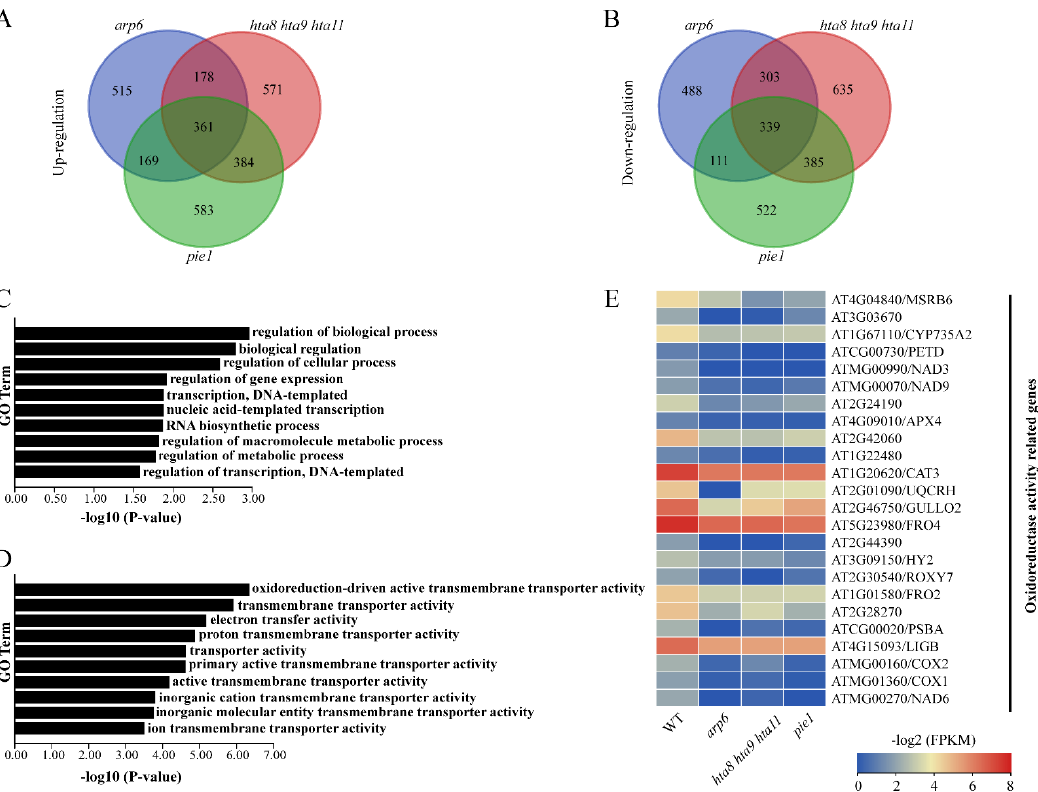
Figure 2. Transcriptomic analysis of WT, arp6 , hta8 hta9 hta11 , and pie1 roots: ( A , B ) Venn diagrams show the number of upregulated genes ( A ) and downregulated genes ( B ) in the roots of arp6 , hta8 hta9 hta11 , and pie1 compared to WT. ( C , D ) GO enrichment analysis of upregulated genes ( C ) and downregulated genes ( D ). ( E ) Expression pattern of oxidoreductase activity-related genes in WT, arp6 , hta8 hta9 hta11 , and pie1 roots.